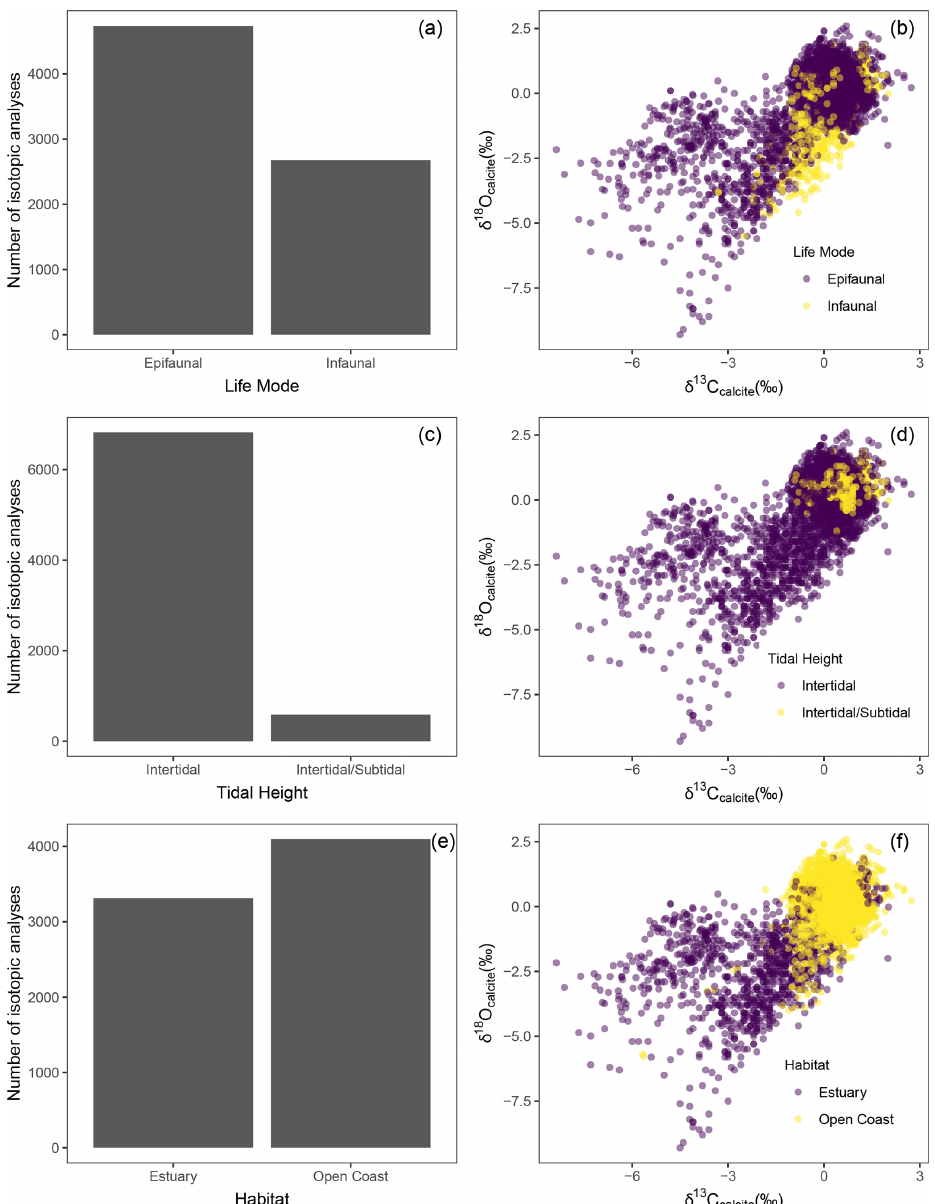
Figure 4. Ecological distribution of data. Histogram and oxygen vs. carbon isotopes are respectively colored by category for life mode (a, b) , tidal height (c, d) , and habitat (e, f)